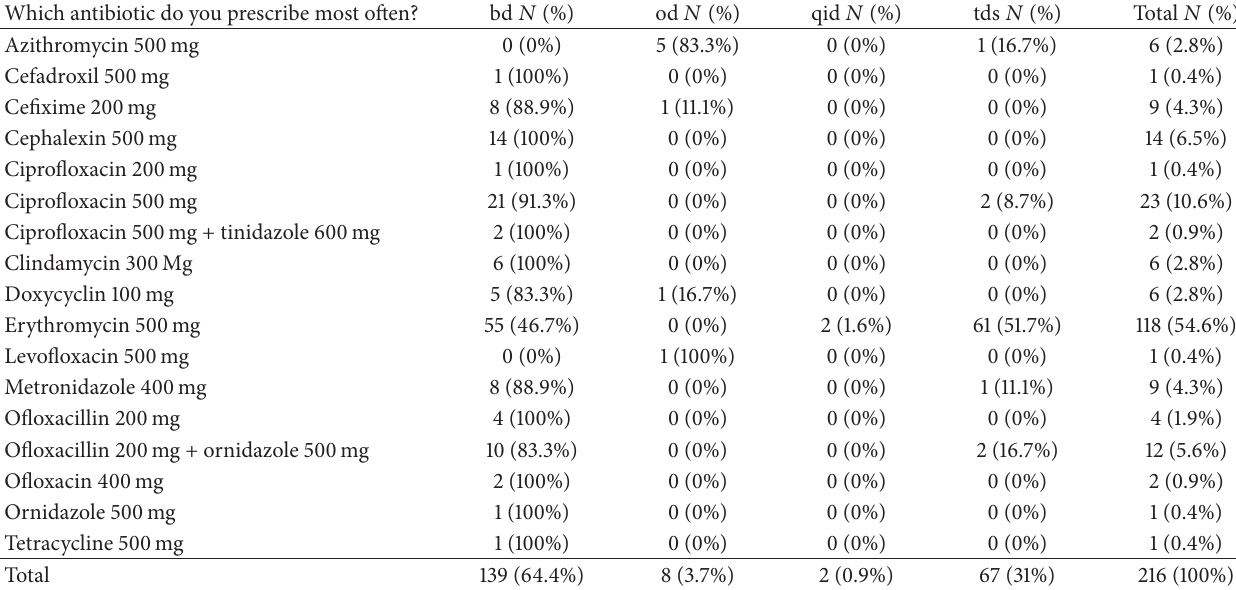
Table 3: Type, dose, and frequency of antibiotic prescription for an adult patient with allergy to penicillin. Which antibiotic do you prescribe most often?